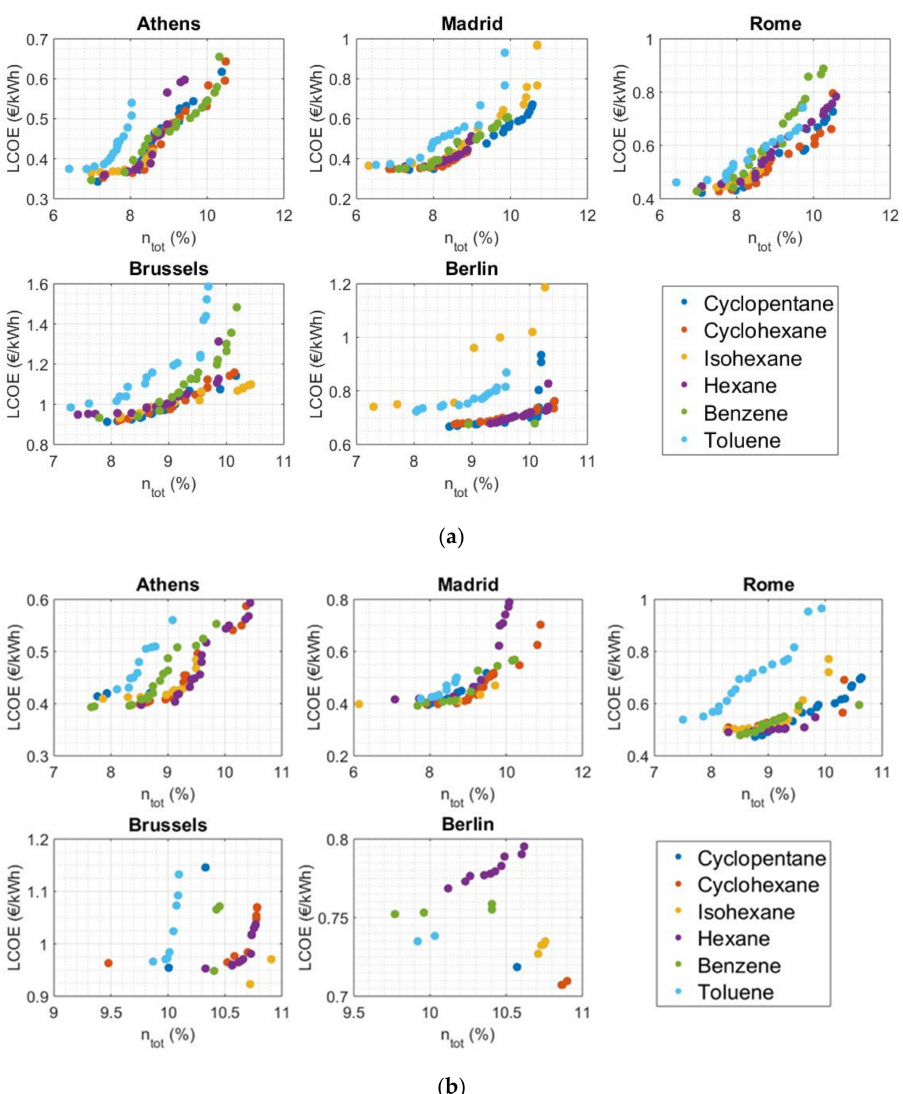
Figure 5. Pareto fronts (LCoE- η tot ) for the considered working fluids in the examined cities for ( a ) PTCs and ( b )